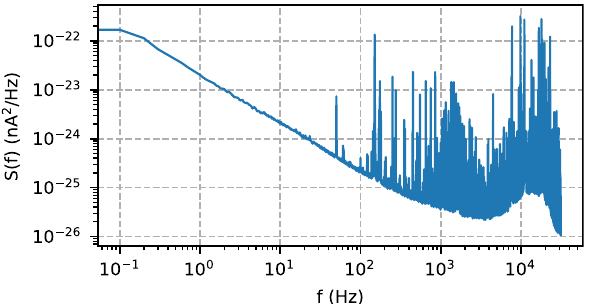
Figure 4. Experimentally measured power spectral density used to generate the colored noise for the synthetic data to train network D